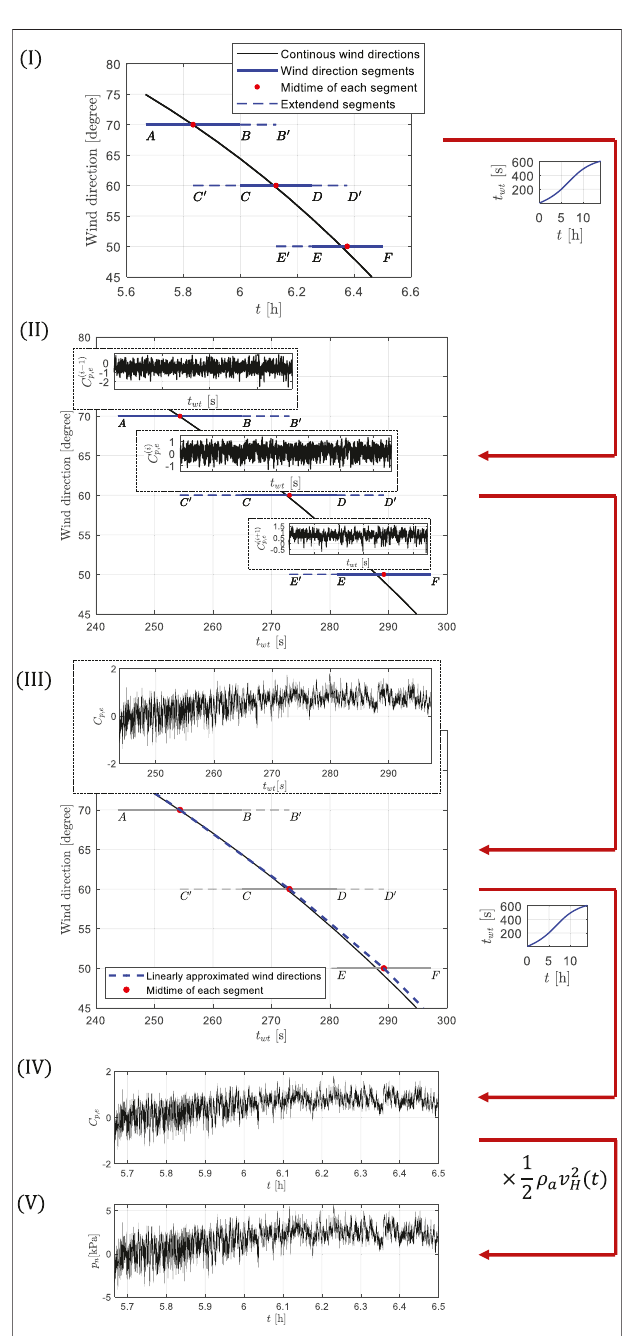
FIGURE 1 | Conceptual fl owchart of the non-stationary/-straight/- Gaussian stochastic wind pressure simulation model.